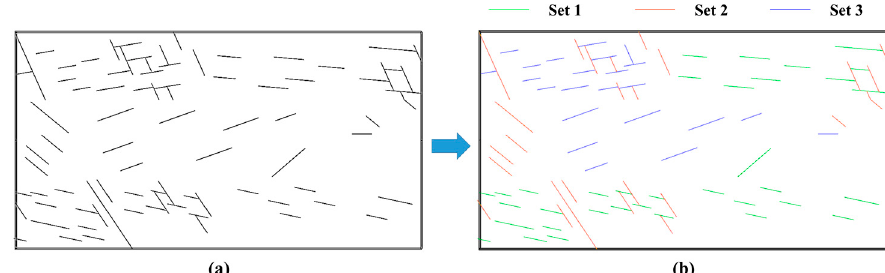
Figure 5. The fracture sketch picture and the fracture dominant sets diagram of the fracture network in the exposed surface: ( a ) Fracture sketch picture and ( b ) Fracture dominant sets diagram.